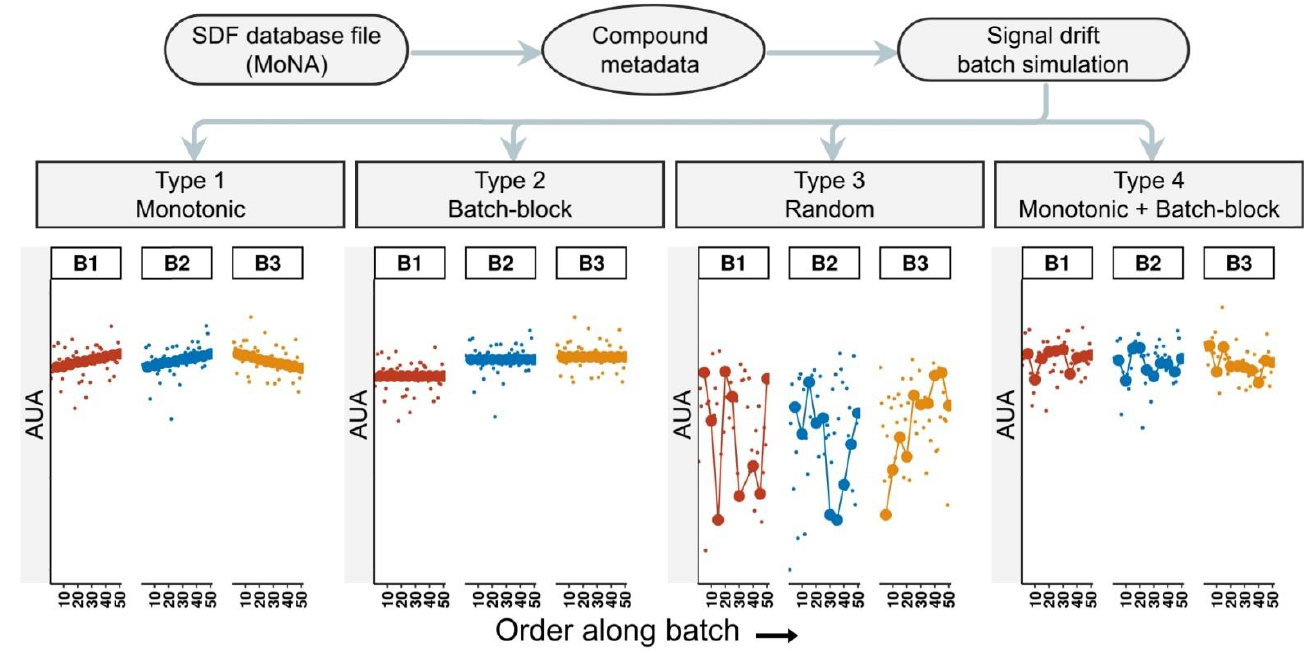
Figure 1. Simulated data produced by the ‘simulate_data()’ function. For each compound queried in the user provided structure-data file (SDF), a simulated peak area matrix with arbitrary units of area (AUA) is returned, along with four additional matrices, each with a different signal drift effect type applied. SDF files are available through the MassBank of North America (MoNA). The larger points in each plot represent the simulated QC samples, and smaller points represent non-QC simulated data points.